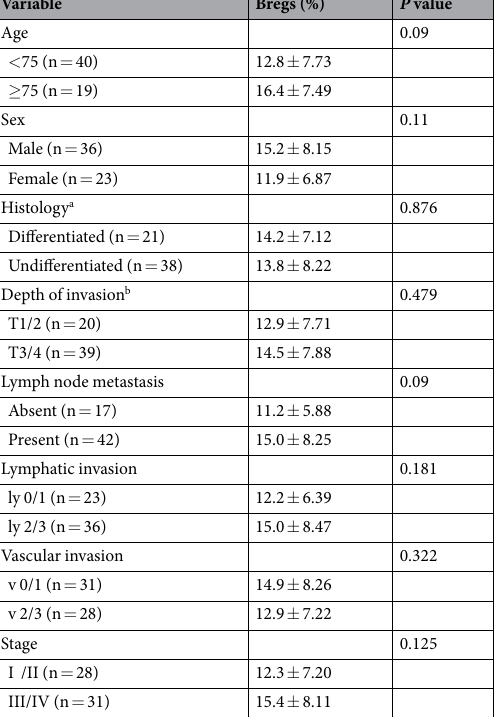
Table 2. Frequency of tumor-infiltrating Bregs and clinicopathological variables in gastric cancer patients. See Table 1 for details of histology and depth of invasion. All results are expressed as the mean ± SD.